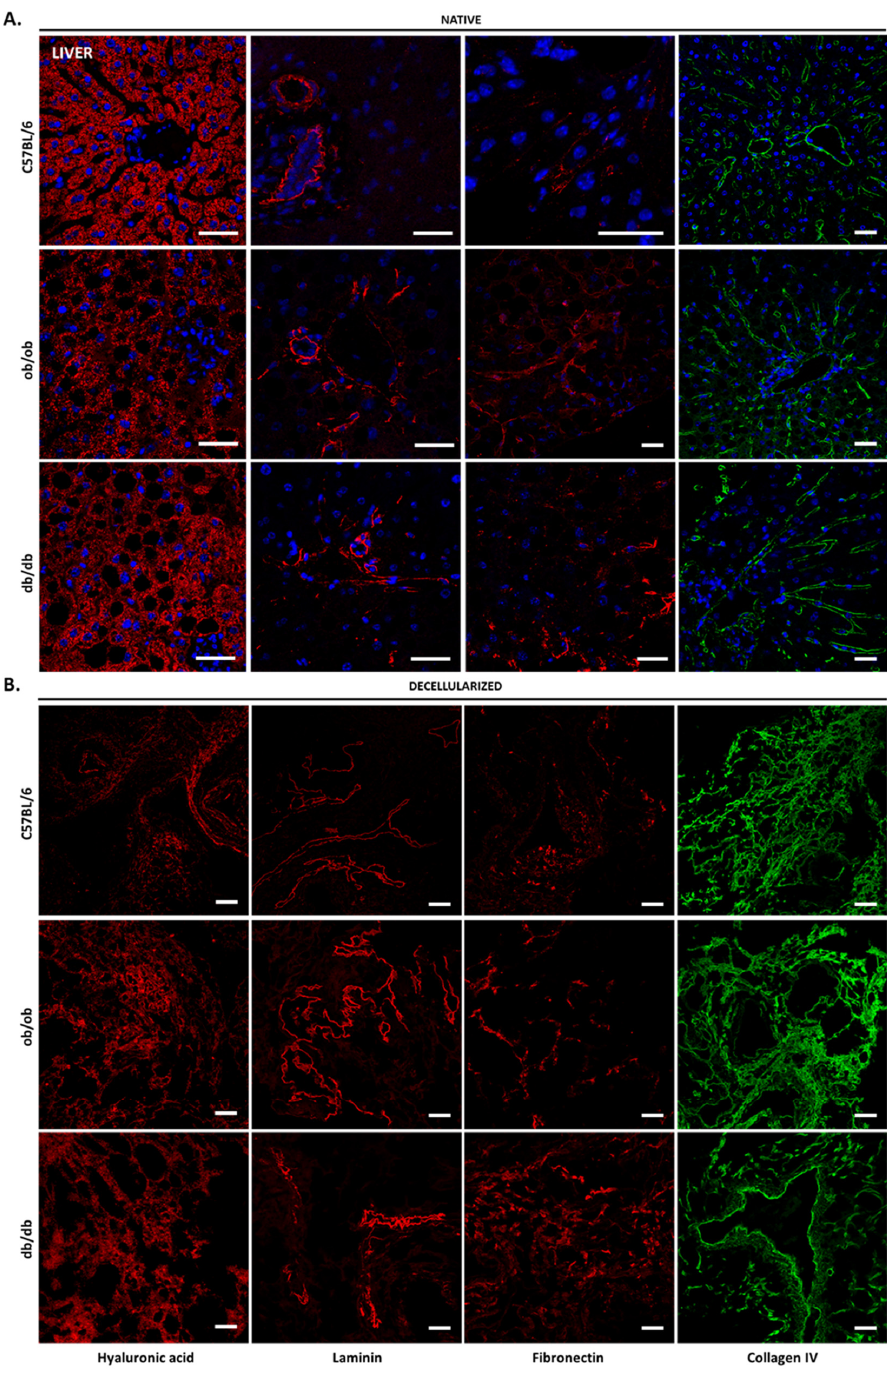
Figure 7. ECM components of native and decellularized liver. Immunohistochemical staining of ECM components from native ( A ) and decellularized ( B ) liver sections of C57BL/6J, ob/ob, and db/db mice. Confocal microscopy images of hyaluronic acid (first column), laminin (second column), fibronectin (third column), and collagen IV (forth column) immunostained liver samples. Nuclei are stained in blue (with DAPI). Scale bar: 100 µm.